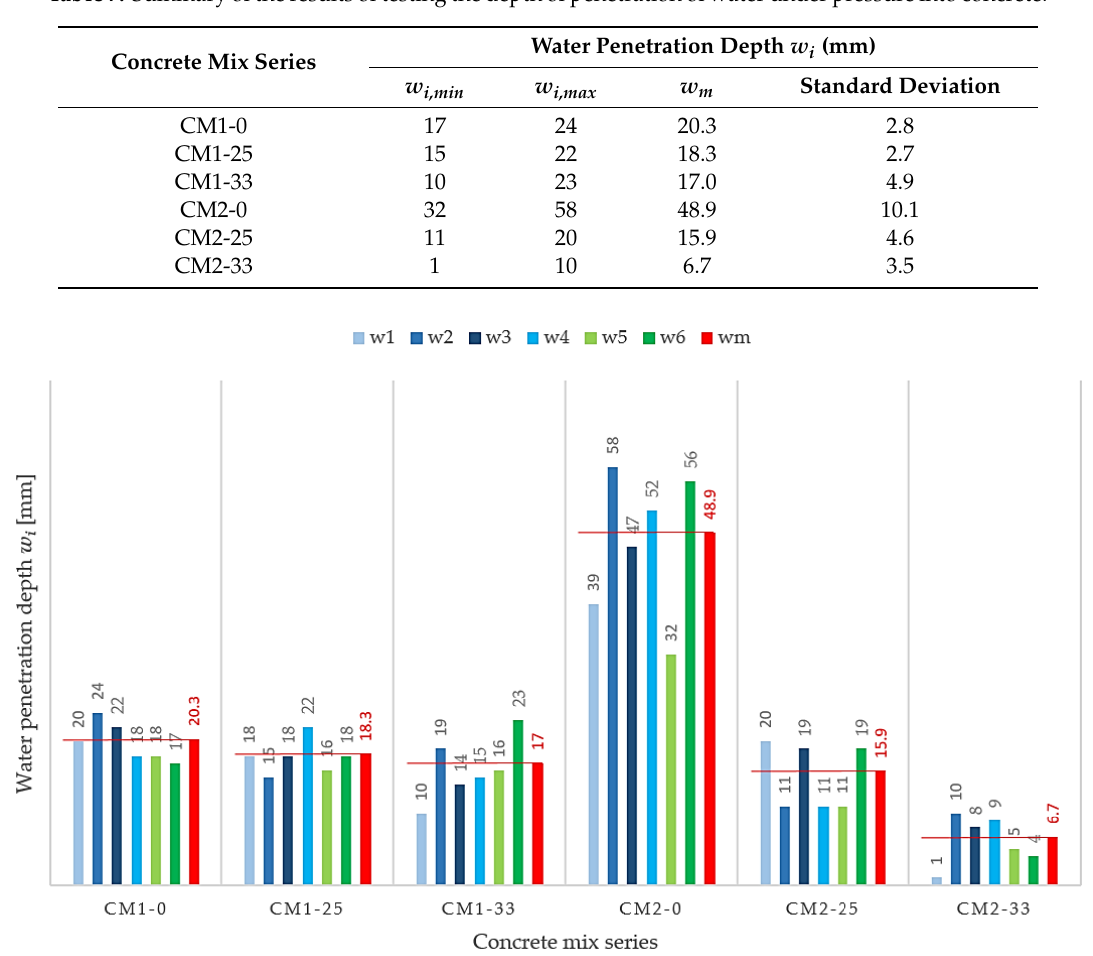
Figure 3. The depth of penetration of water under pressure into concrete for the tested mix series.